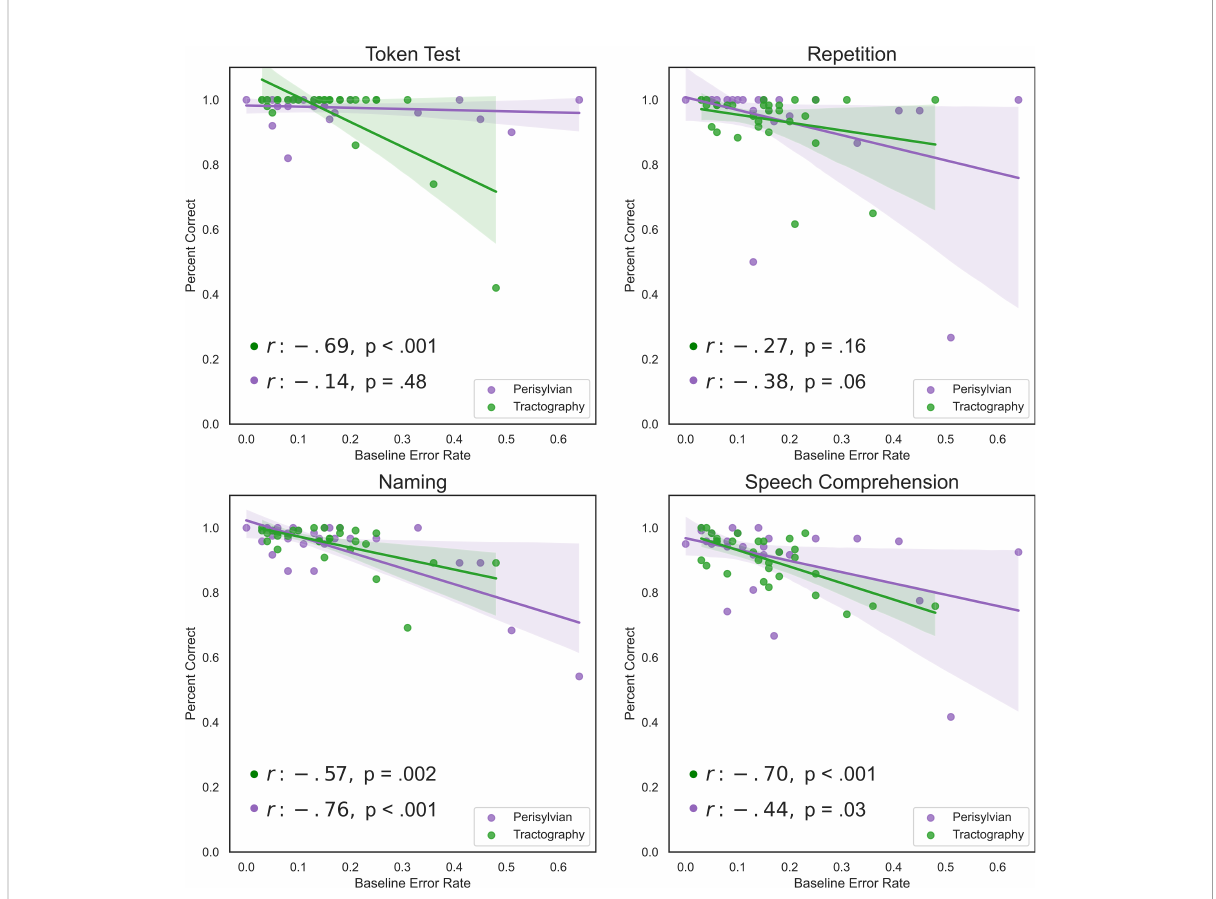
FIGURE 4 Linear regression charts between baseline ERs and the pre-operative AAT subtests. Subtests include the token test, repetition test, naming test and speech comprehension test of spoken and written language. Plotted are the percentages achieved for each test out of 100%. Regression models are visualized for perisylvian (purple) and tractogram-based (green) protocols. Legends for each subplot contain the correlation coef fi cient (r) and corrected p-values using the Benjamini – Hochberg procedure.